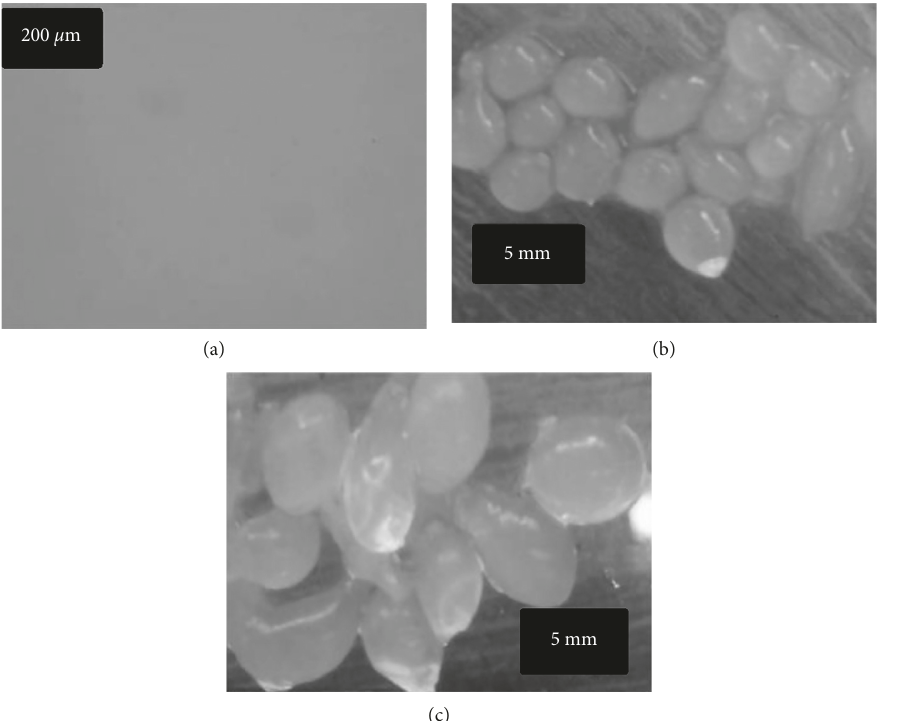
Figure 9: Optical microscope images of hydrogel samples made of AA 3% by (a) ionotropic gelation with CaCl 2 1% w/v, (b) polyelectrolyte complexation with CS 0.01% w/v, and (c) combination of ionotropic gelation and polyelectrolyte complexation (CaCl 2 1% w/w). Table 1: Zeta potential for samples made by polyelectrolyte complexation and ionotropic gelation-polyelectrolyte complexation. Zeta potential (mV) ionotropic gelation + Zeta potential (mV) polyelectrolyte Anionic polymer/CS ratio polyelectrolyte complexation